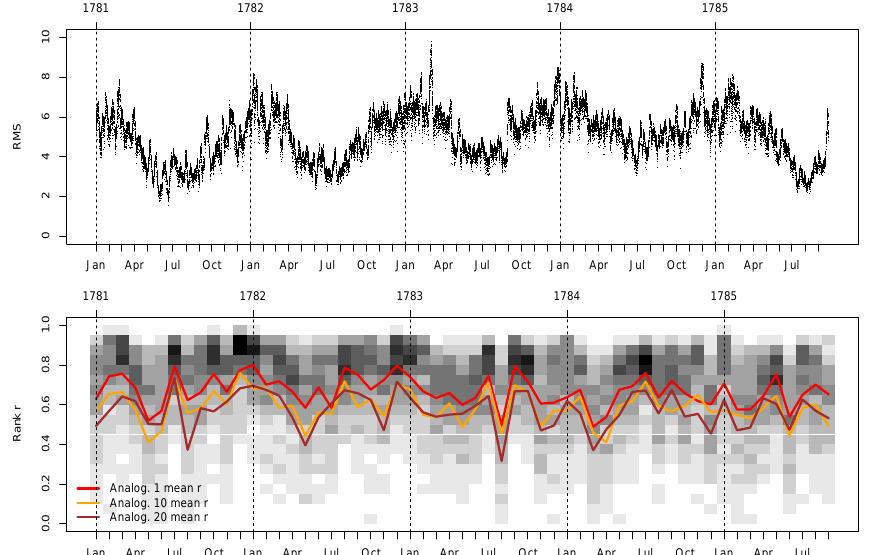
Fig. 2. Scores (correlation and RMS) of analogues. Upper panel: RMS values between Kington (1988) SLP anomalies and analogues in NCEP, between 1781 and 1785 for each day and all 20 analogues. Each day yields 20 dots (one for each analogue). Lower panel: monthly averages of spatial rank correlation between the Kington (1988) SLP anomalies and 20 best analogues from RMS (lines). The shaded squares represent the probability distribution of the correlation values (dark greys indicate higher probability) for each month, for 20 analogues and daily reconstructions. The red line represents the monthly mean of Spearman correlations between the first (i.e. with lowest RMS) analogue and the Kington SLP anomalies. The orange and brown lines represent mean score values for the 10th and 20th analogues (median and worst RMS among the 20